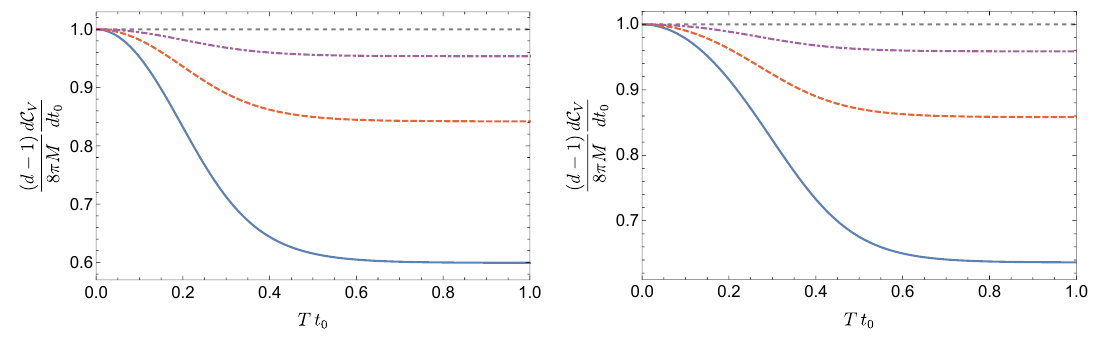
Figure 7 . Rate of change of complexity evaluated from the complexity=volume conjecture in the Vaidya-AdS spacetime for the BTZ black hole with the Neveu-Schwarz vacuum for several values of the temperature, i.e., for TL = 0 : 16 (blue), TL = 0 : 32 (red, dashed) and TL = 0 : 64 (purple, dot-dashed).